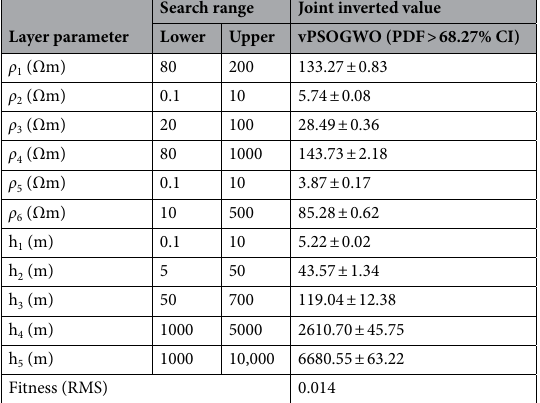
Table 12. Mean model with the level of uncertainty in the posterior utilizing vPSOGWO joint inversion of DC and MT data over Central Puga Valley, India.